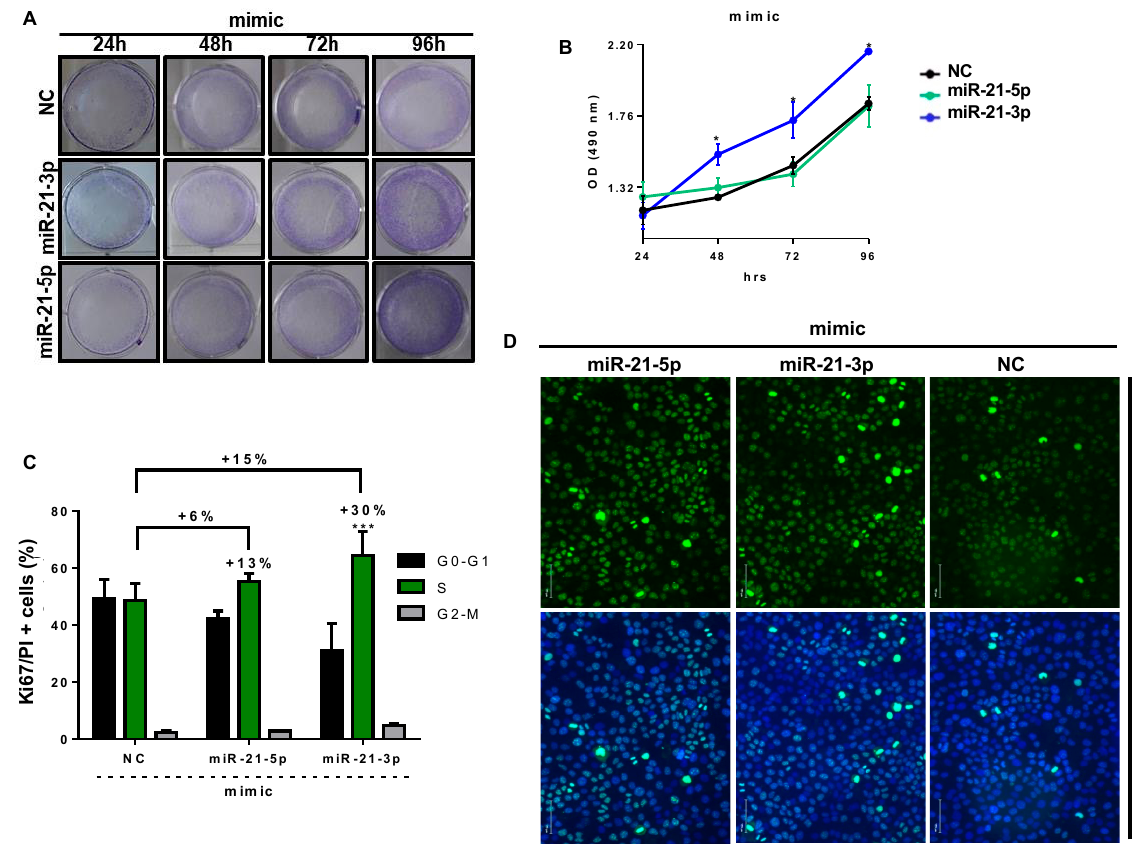
Figure 8. miR ‐ 21 ‐ 3p gain of function promotes KC proliferation. ( A ) Crystal violet staining at different time pointa (24 h, 48 h, 72 h, and 96 h) of HaCaT cells transfected with negative control (NC) or miR ‐ 21 ‐ 5p or miR ‐ 21 ‐ 3p mimics. ( B ) XTT assays at different time points (24 h, 48 h, 72 h, and 96 h) of HaCaT cells transfected with negative controls (NC), miR ‐ 21 ‐ 5p or miR ‐ 21 ‐ 3p mimics. ( C ) Cell cycle analysis with double Ki ‐ 67/PI staining 24 h post ‐ transfection of HaCaT cells with negative control (NC) or miR ‐ 21 ‐ 5p or miR ‐ 21 ‐ 3p mimics. ( D ) Ki67 immunostaining 24 h post transfection of HaCaT cells with negative control (NC) or miR ‐ 21 ‐ 5p or miR ‐ 21 ‐ 3p mimics. Data information: results are presented as mean values ± SEM. Data are representative of three independent experiments performed in triplicate. The statistical comparison between groups was performed by using the two ‐ way ANOVA test: * p < 0.05, *** p < 0.001.